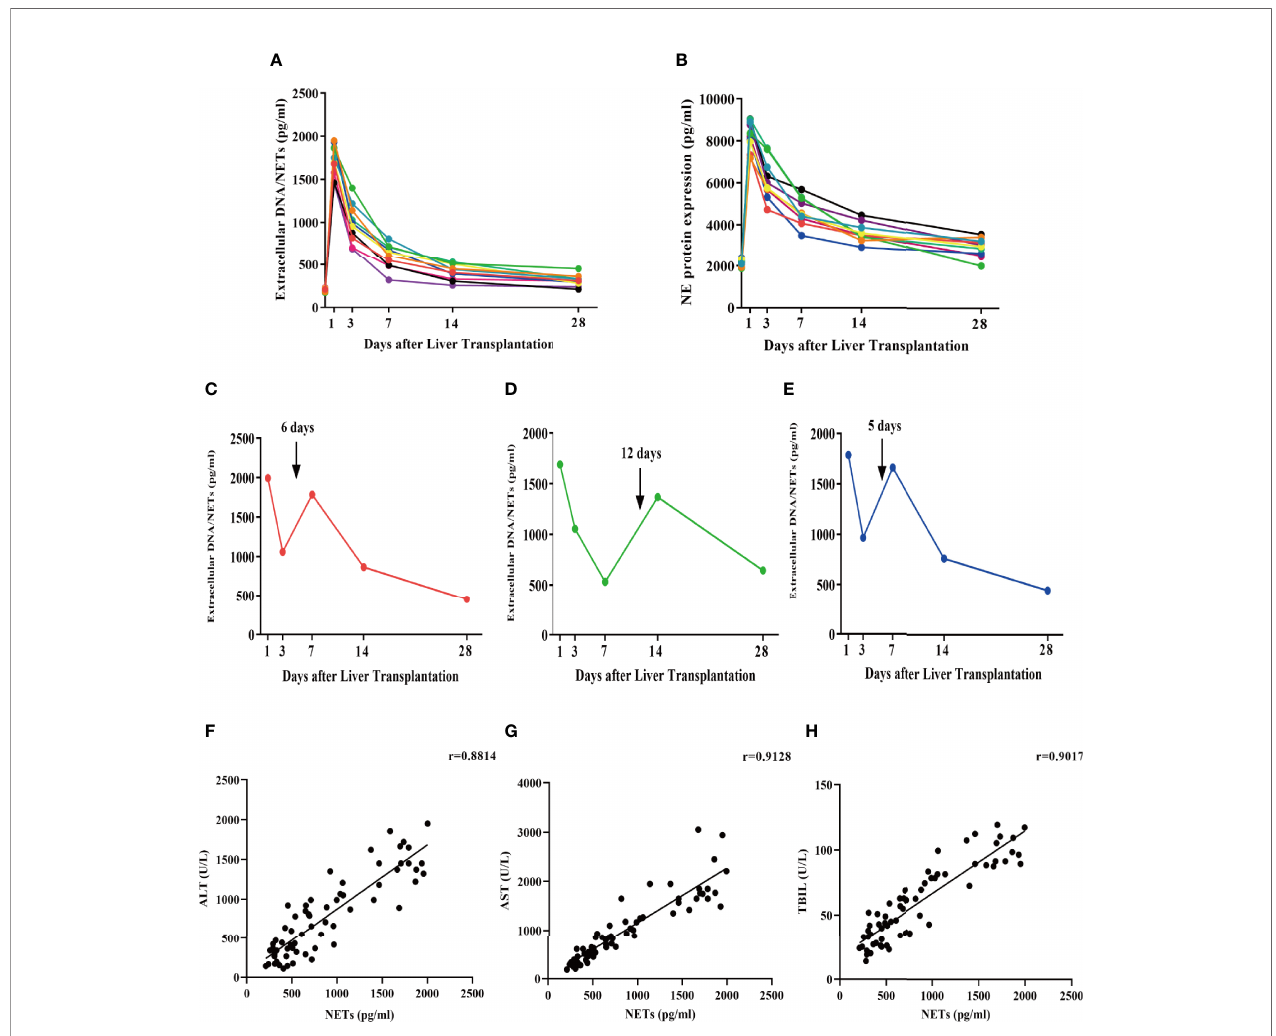
FIGURE 3 | Serum extracellular NETs and circulating NETosis products are increased in patients undergoing liver transplantation. (A, B) Extracellular NET and NET levels (NE) were determined in the serum of patients undergoing liver transplantation without AR at days 1, 3, 7, 14, and 28. (C – E) Extracellular NETs were measured in the serum of liver transplantation patients with AR at days 1, 3, 7, 14, and 28. (F – H) Pearson correlation analysis of NETs with ALT, AST, and